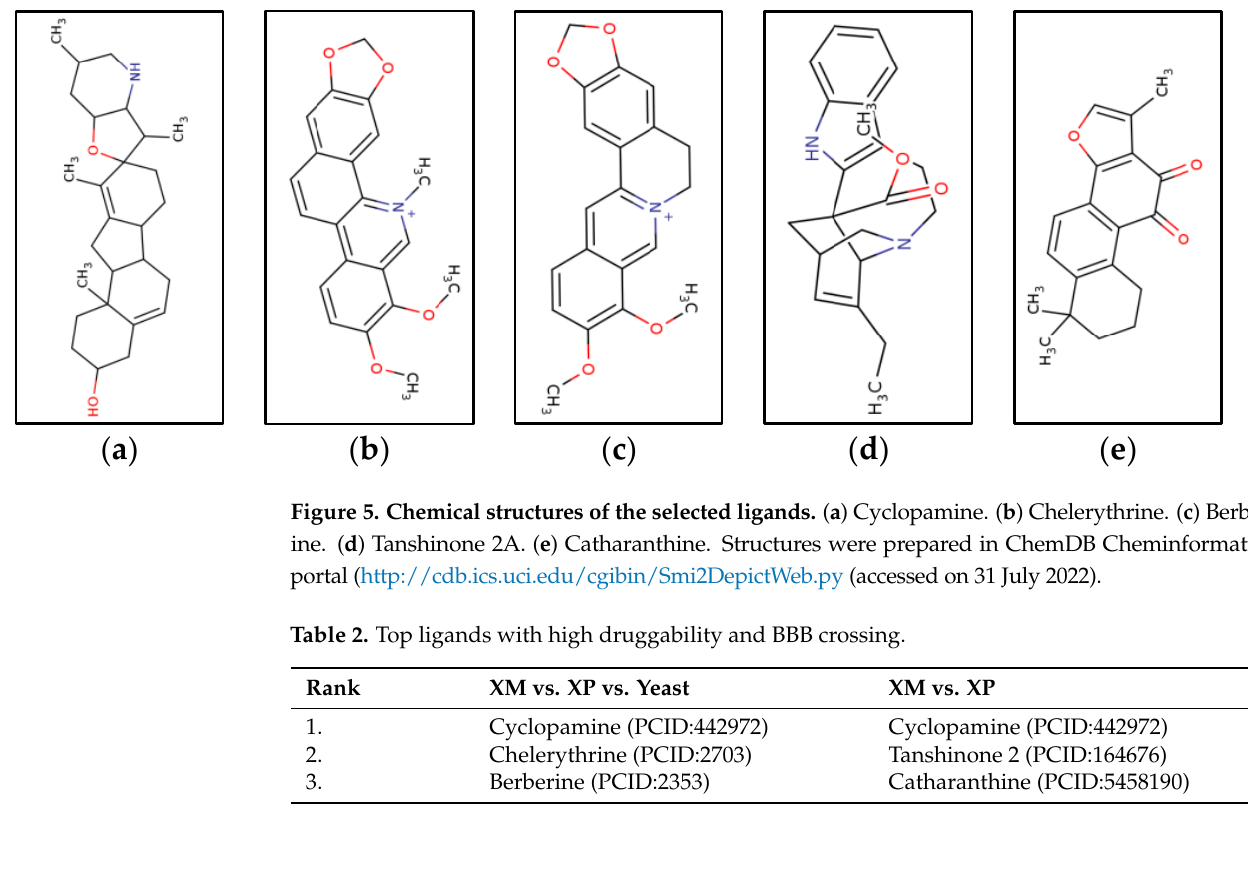
Table 3. Drug likeness and ADME results for Top ligands.